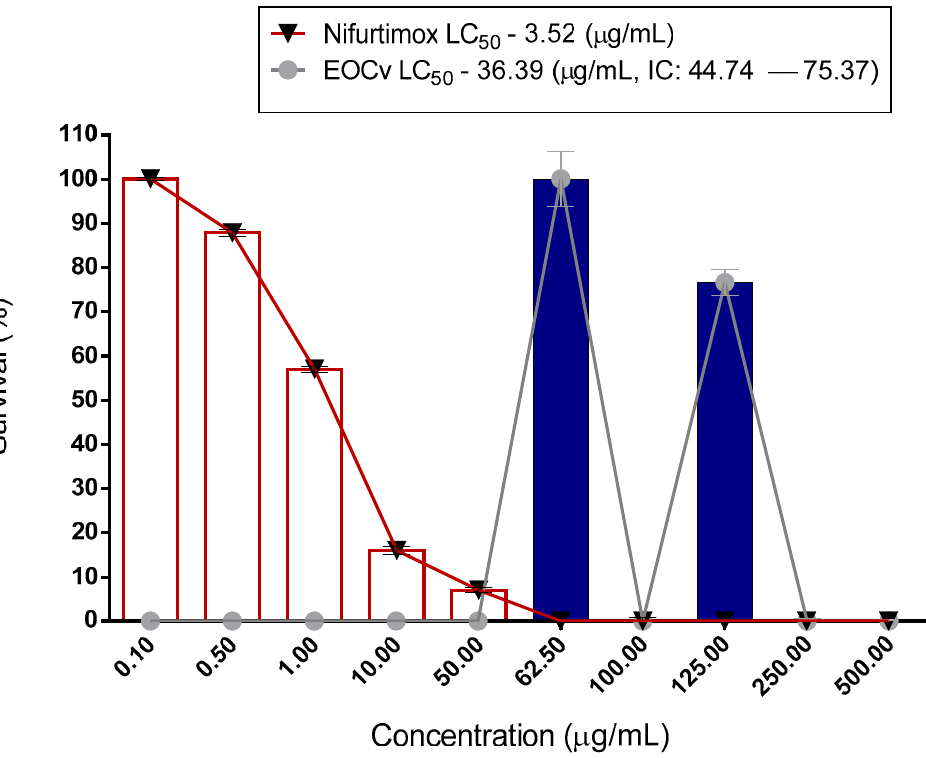
Figure 3. Survival of the epimastigote T. cruzi treated with C. verbenaceae essential oil. LC 50 confidence interval for oil: 95% (44.74–75.37). EOCv (essential oil of C. verbenaceae ). Table 4. Survival of the epimastigote T. cruzi treated with C. verbenaceae essential oil. Natural Product